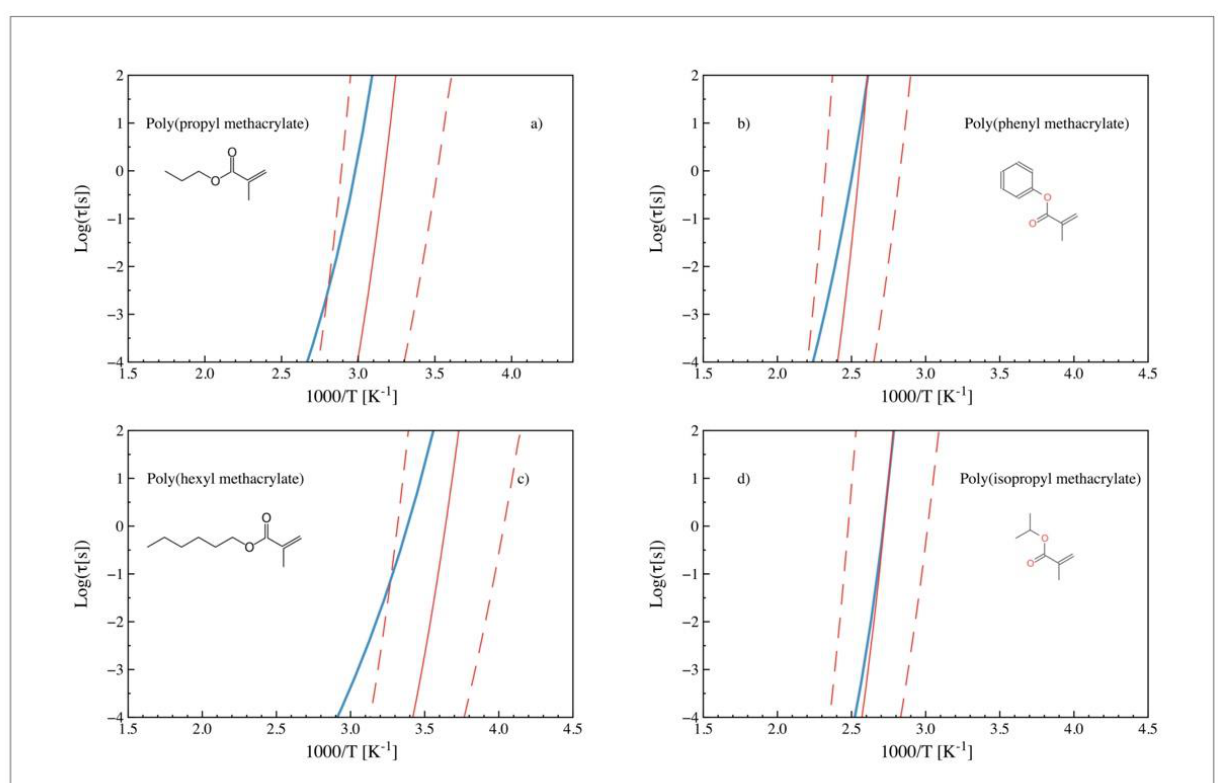
Figure 4. Experimental (blue) and predicted (red) relaxation times (obtained from ECNLE theory) vs. 1000/T after introducing the scaling parameter ( a ). Dashed lines stand for the confidence interval corresponding to the typical deviation in the ANN prediction (10% relative error). ( a ) Poly (propyl methacrylate), ( b ) poly (phenyl methacrylate), ( c ) poly (hexyl methacrylate) and ( d ) poly (isopropyl methacrylate) .